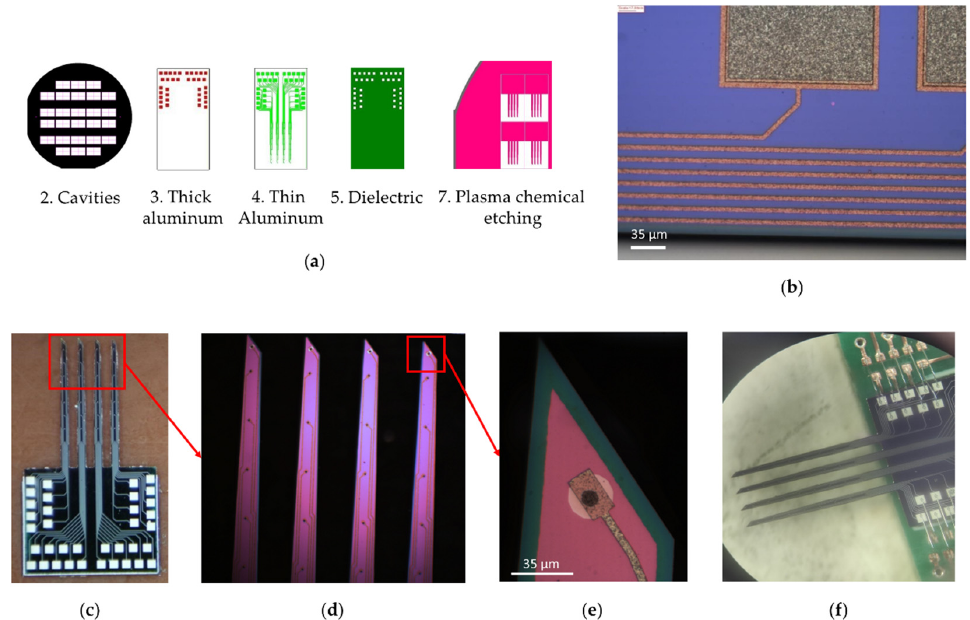
Figure 4. Multi-electrode array. ( a ) Photomasks with drawings of functional layers of a multi-electrode array; ( b ) Elements of two-level aluminum metallization (matt gray is contact pads; light brown is conductive tracks); ( c ) 36-channel electrode wafer; ( d ) Enlarged view of MEA silicon needles (4 needles, 5 mm long, 260 µ m average width and 50 µ m thick); ( e ) Enlarged view of MEA needle tip (green represents first layer of insulating silicon dioxide, red represents second layer of insulating silicon dioxide, white represents gold contacts, brown represents aluminum pads, black represents electrical connection between golden and aluminum pads); ( f ) 32-channel multi-electrode array soldered with gold on a special board, one channel on each of the four needles was used to control the conductivity of the MEA